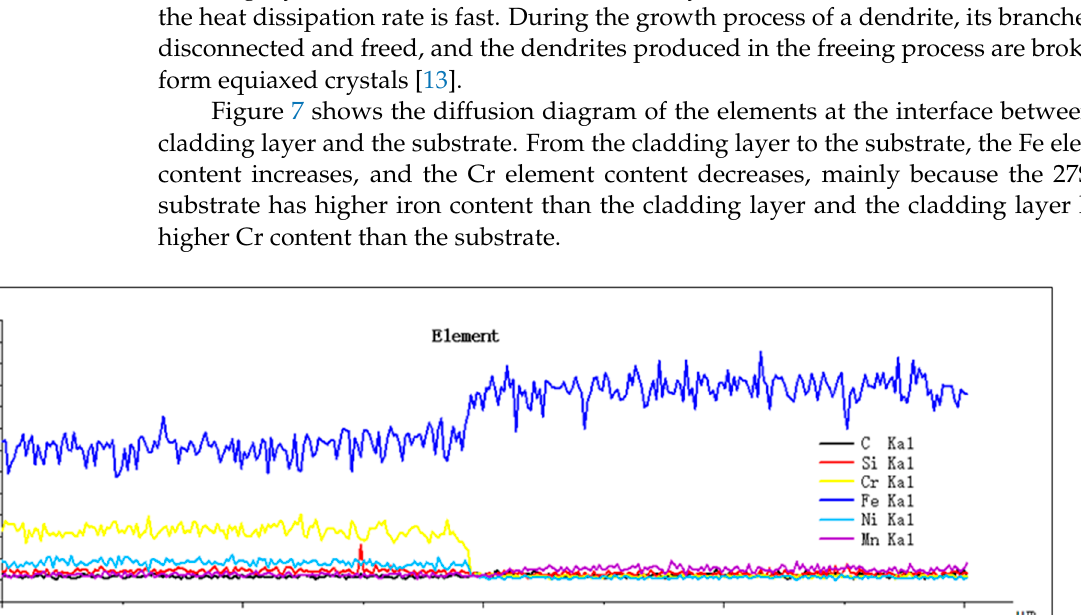
( b ) Figure 8. Scanning of the upper and middle regions of the cladding layer. ( a ) Upper area of the cladding layer; ( b ) mid- dle area of the cladding layer. 3.4. Hardness Testing Figure 9 shows the microhardness of the cladding layers of Samples A and B. It can be observed from Figure 9 that the hardness values of the cladding layers of Samples A and B are higher than that of the substrate and distributed in a stepped manner. The hardness in the cladding area is much higher than that of the matrix. Approaching the heat-affected zone, the hardness begins to decrease, and the hardness in the heat-affected zone gradually decreases to the hardness of the matrix. In the cladding zone, this is mainly due to the hard phases such as borides and carbides crystallized. In the heat-affected zone, the liquid metal rapidly solidifies, and base remelting occurs. The mixing degrees of the cladding material and the base material are different, resulting in